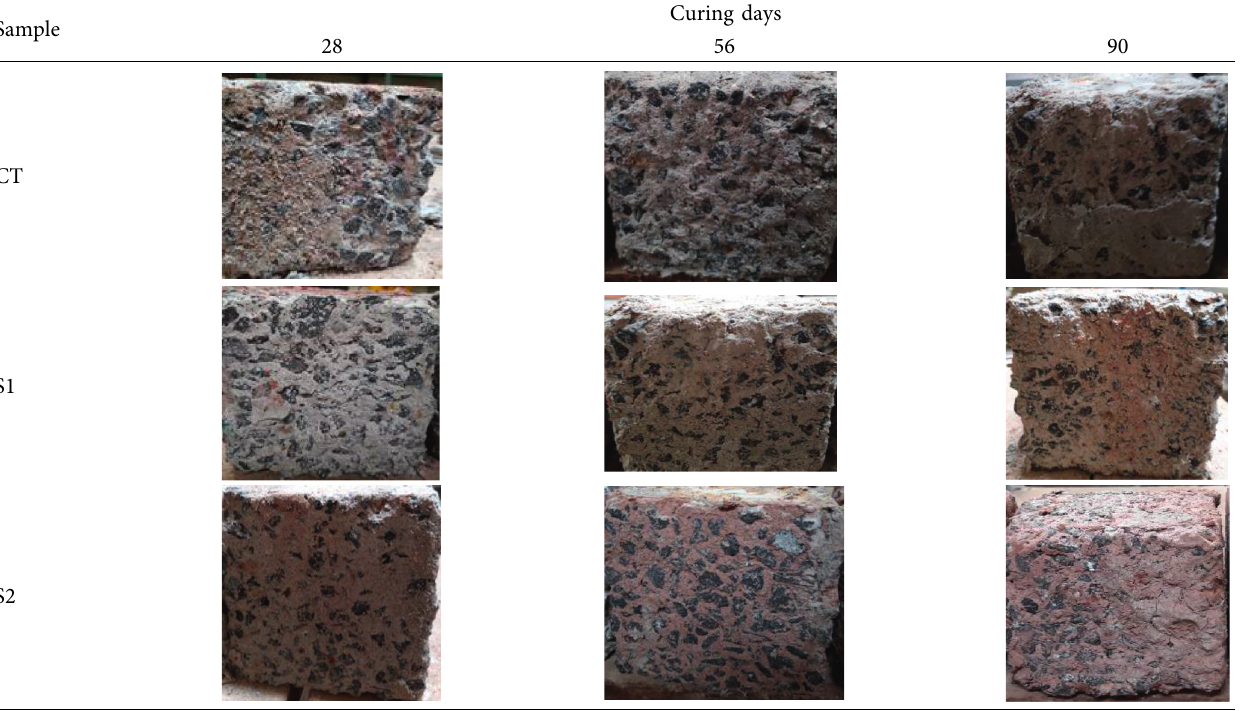
Figure 8: Compressive strength of CT, S1, and S2 immersed in the combined solution of sulphate and chloride. Table 8: Physical characteristics of concrete mixes after exposure to sulphate and chloride solution: large peeling of the surface visible. Sample